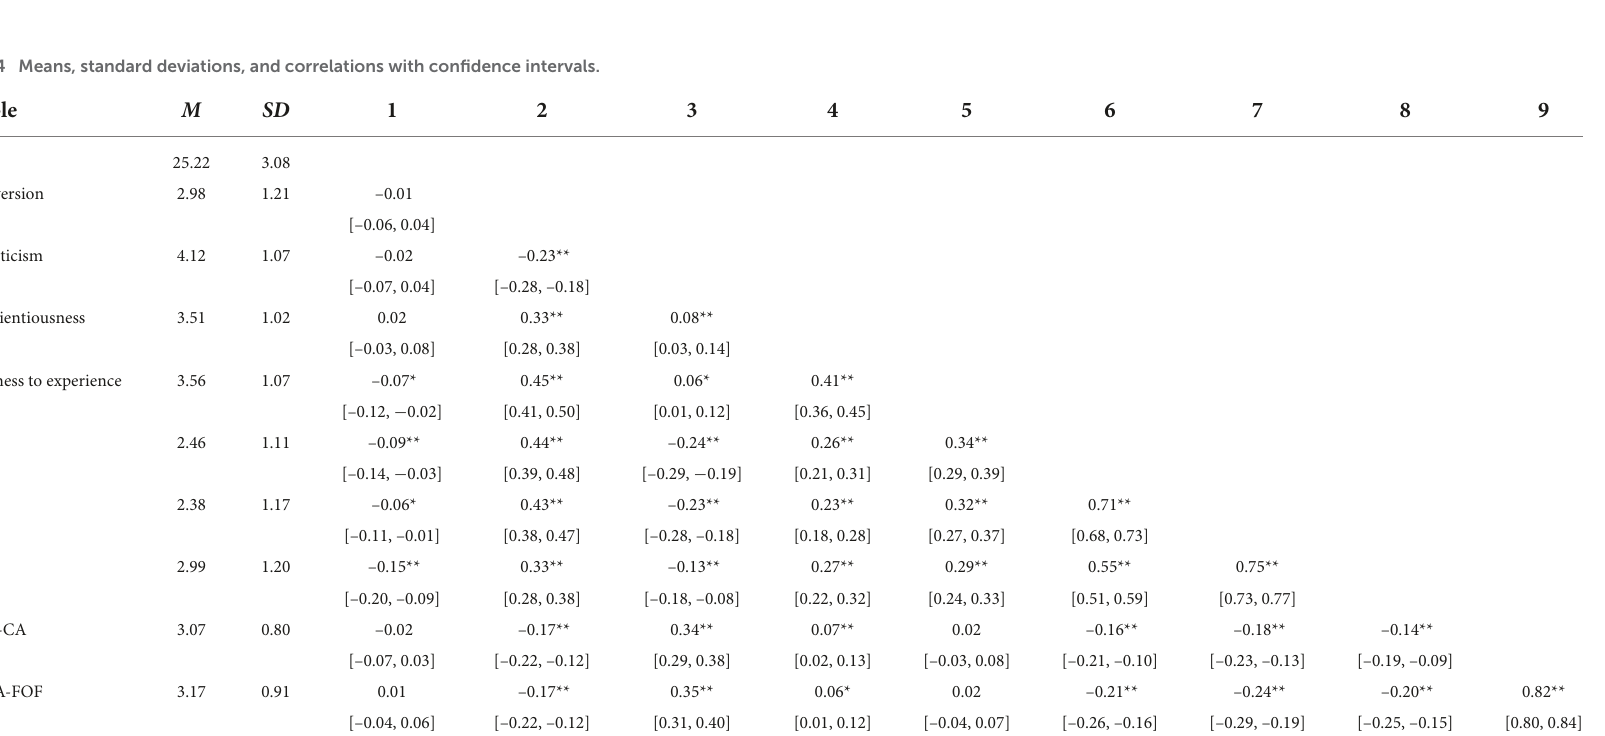
M and SD are used to represent mean and standard deviation, respectively. Values in square brackets indicate the 95% confidence interval for each correlation. The confidence interval is a plausible range of population correlations that could have caused thesamplecorrelation(Cumming,2014). *Indicates p < 0.05. **Indicates p <